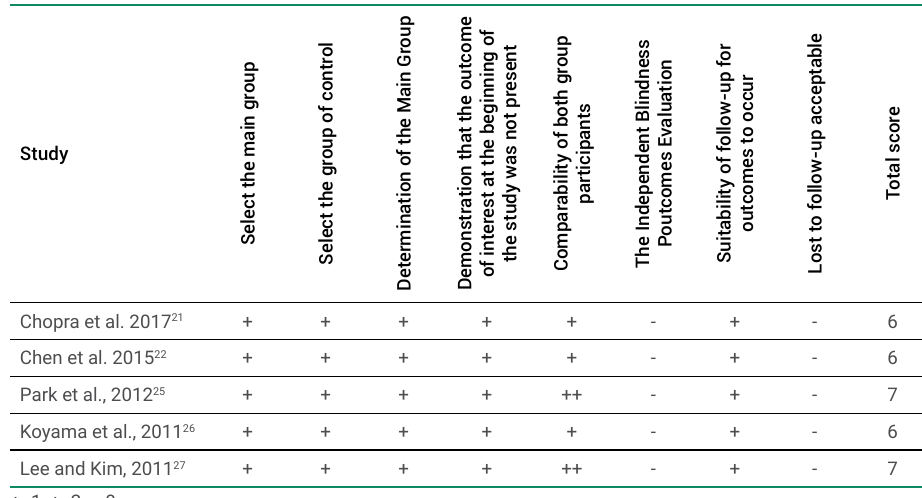
Table 4. Risk of bias assessment (Non-randomized clinical